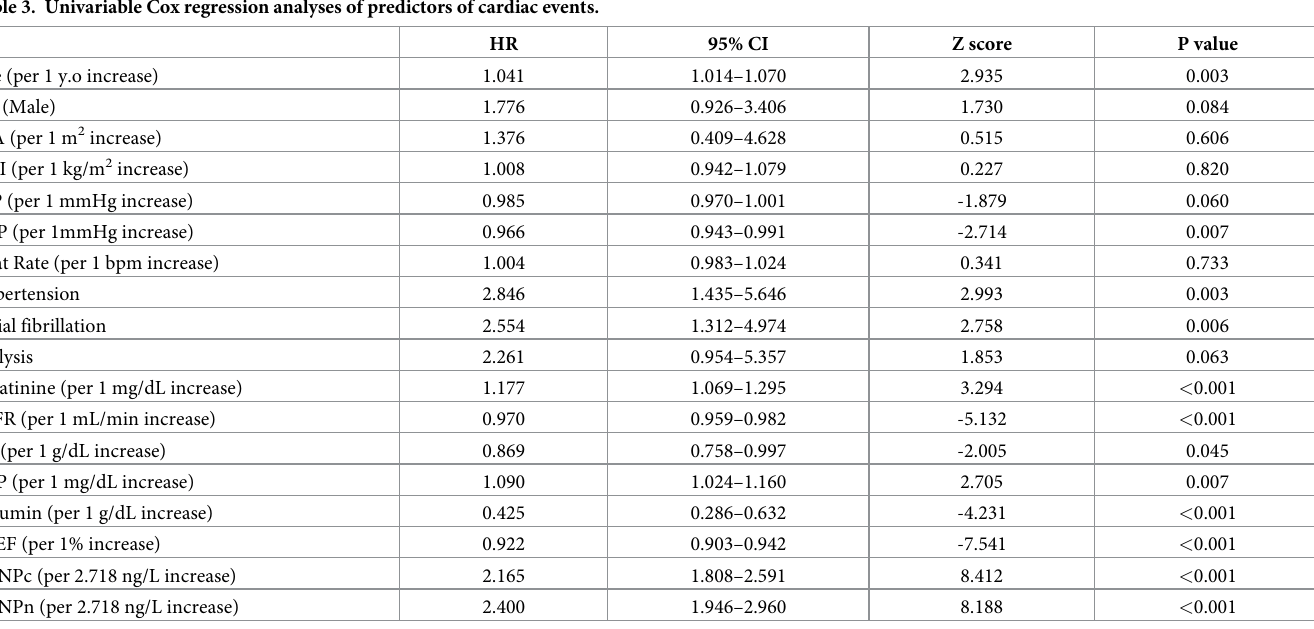
Table 3. Univariable Cox regression analyses of predictors of cardiac events. HR 95% CI Z score P